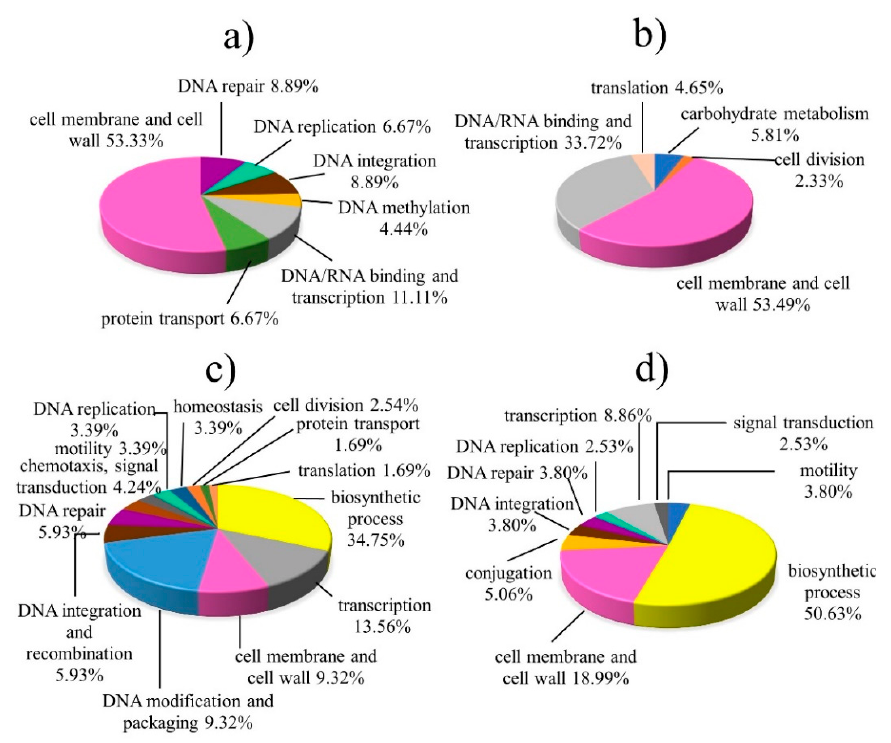
Figure 3. Functional profiles of identified proteins expressed in peptide-treated plant pathogens (but not found in antibiotic treated or control samples): ( a ) X. oryzae pv. oryzae with peptide no. 1, ( b ) X. oryzae pv. oryzae with peptide no. 5, ( c ) Pectobacterium carotovorum with peptide no. 2, and ( d ) A. rhizogenes with peptide no. 2.